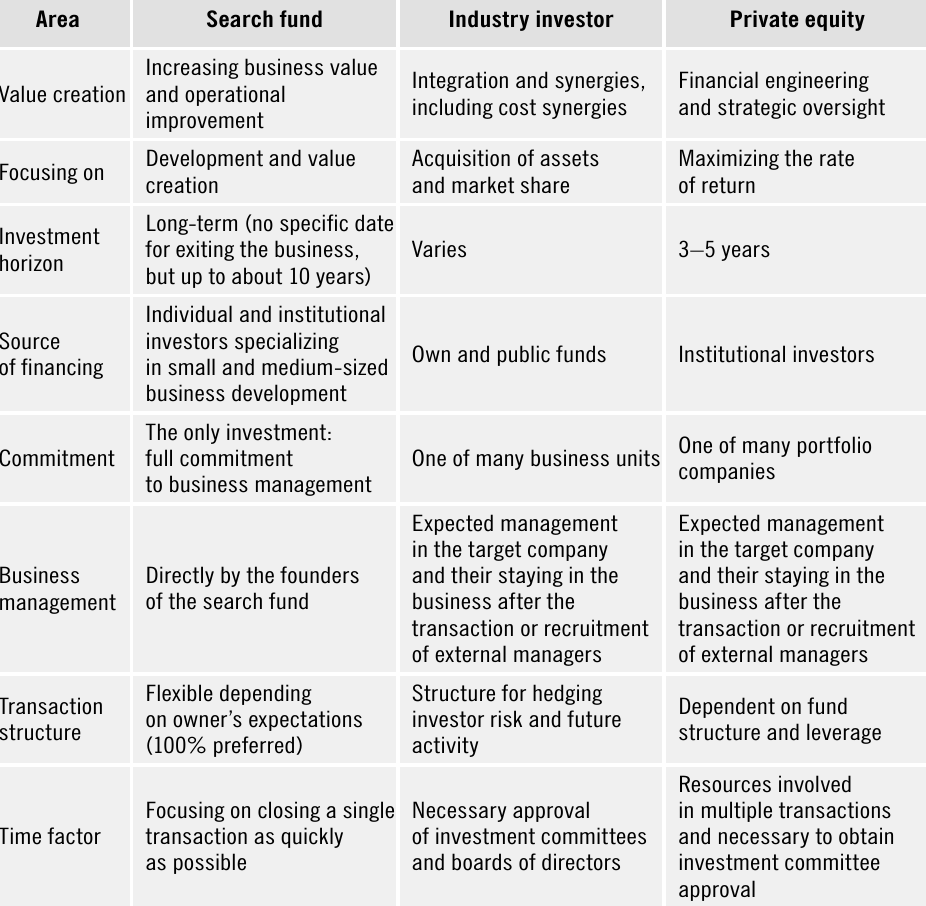
Table 2. Comparison of search fund to other investor